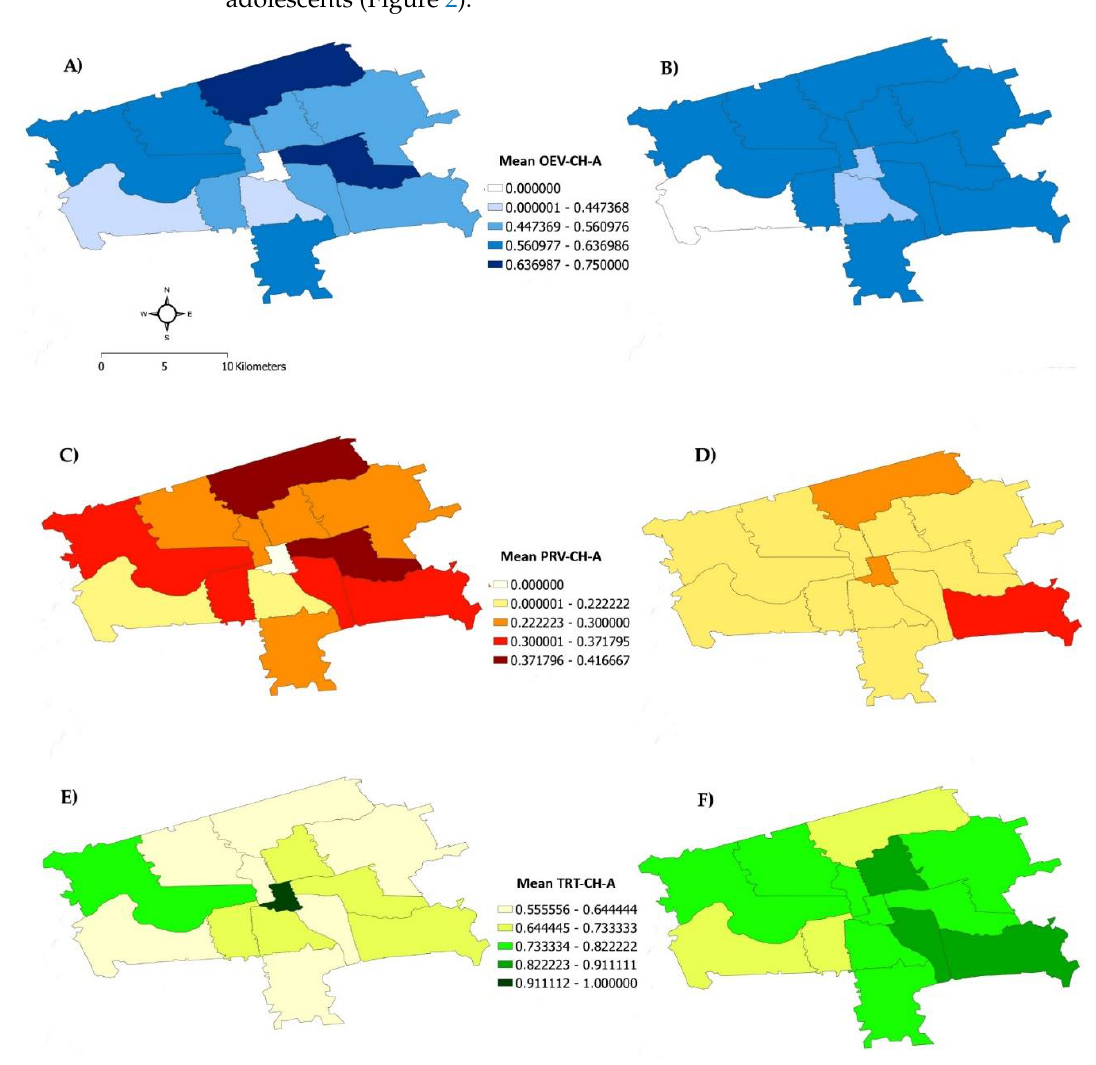
Figure 2. Geographic distribution of dental care outcome variables: ( A , B ) routine oral evaluation (OEV-CH-A), ( C , D ) preventive services (PRV-CH-A), and ( E , F ) dental treatment services (TRT-CH-A). Data for adolescents are shown in ( A , C , E ). Corresponding data for young adults are shown in ( B , D , F ). Numerical values represent mean DQA scores on a scale from 0 to 1. Distance scale in A applies to all panels. To facilitate visualization, the maps include only FSA codes ( n = 14) that fall within the city limits of London, Ontario.